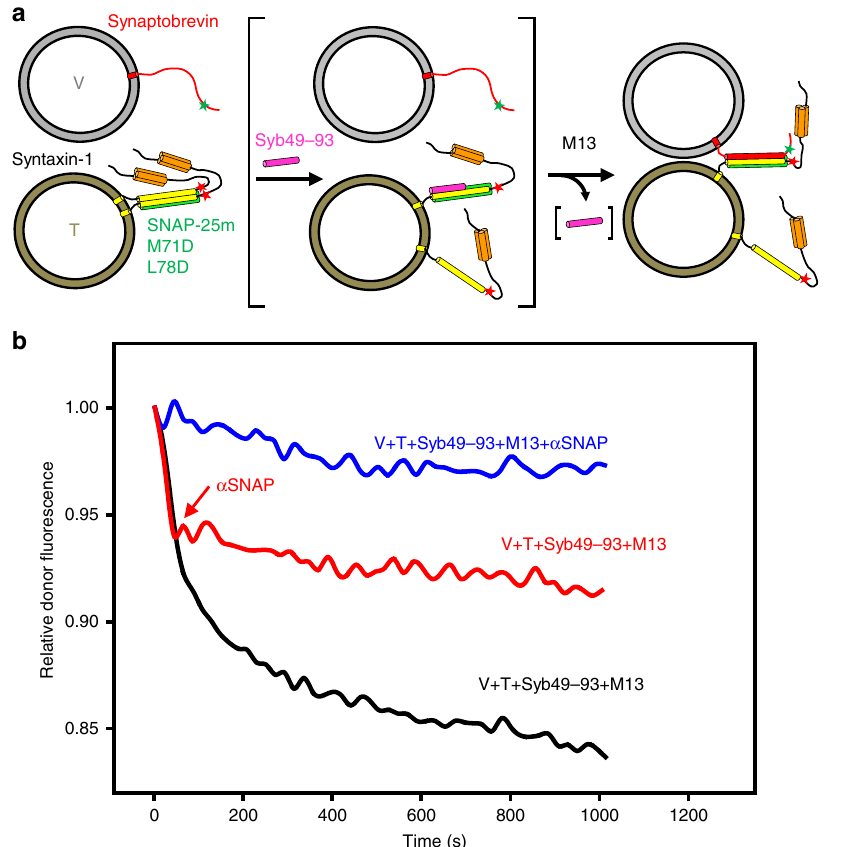
Fig. 6 α SNAP inhibits trans -SNARE complex assembly. a Diagram illustrating the FRET assay used to monitor trans-SNARE complex assembly 36 . V- liposomes containing synaptobrevin labeled with a FRET donor (Alexa-488, green star) at residue 26 are mixed with T-liposomes containing syntaxin-1 labeled at residue 186 with a FRET acceptor (tetramethylrhodamine, red star) and SNAP-25 bearing a M71D,L78D mutation that prevents membrane fusion. Synaptobrevin is red, SNAP-25 M71D,L78D green, and syntaxin-1 orange (N-terminal H abc domain) and yellow (SNARE motif and TM region). Syntaxin-1-SNAP-25 M71D,L78D complexes are expected to have a 2:1 stoichiometry (left diagram), hindering SNARE complex formation, and the addition of a synaptobrevin fragment spanning the C-terminal part of its SNARE motif (residues 49 – 93; Syb49 – 93) accelerates SNARE complex assembly because it displaces the second syntaxin-1 molecule from the syntaxin-1-SNAP-2 M71D,L78D heterodimer, yielding the intermediate shown between brackets 57 . Syb49 – 93 can be displaced by synaptobrevin on the V-liposomes to form trans -SNARE complexes (right diagram). b Kinetic assays monitoring trans - SNARE complex assembly upon mixing V- and T-liposomes (1:4 ratio) in the presence of 10 µ M Syb49 – 93 and 0.3 µ M M13C 1 C 2 BMUNC 2 C (M13) with (blue trace) or without (black trace) 2 µ M α SNAP. The red trace shows an analogous experiment where 2 µ M α SNAP was not included initially but was added at ~200 s, which immediately stopped trans -SNARE complex assembly. In all assays, the fl uorescence emission intensity of the donor was monitored as a function of time and the data were normalized with the intensity observed in the fi rst point. Source data are provided as a Source Data fi